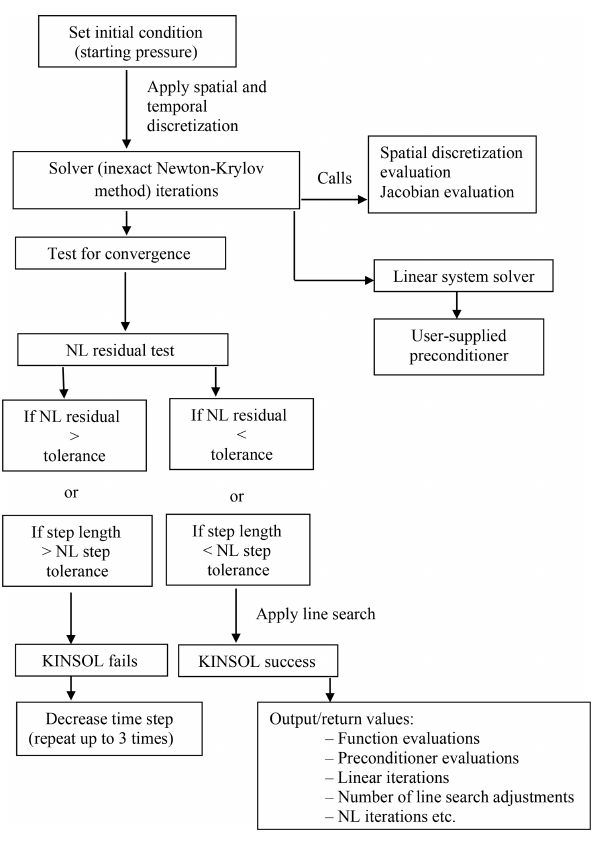
Figure 3. Working flowchart of ParFlow’s solver for linear and non- linear system